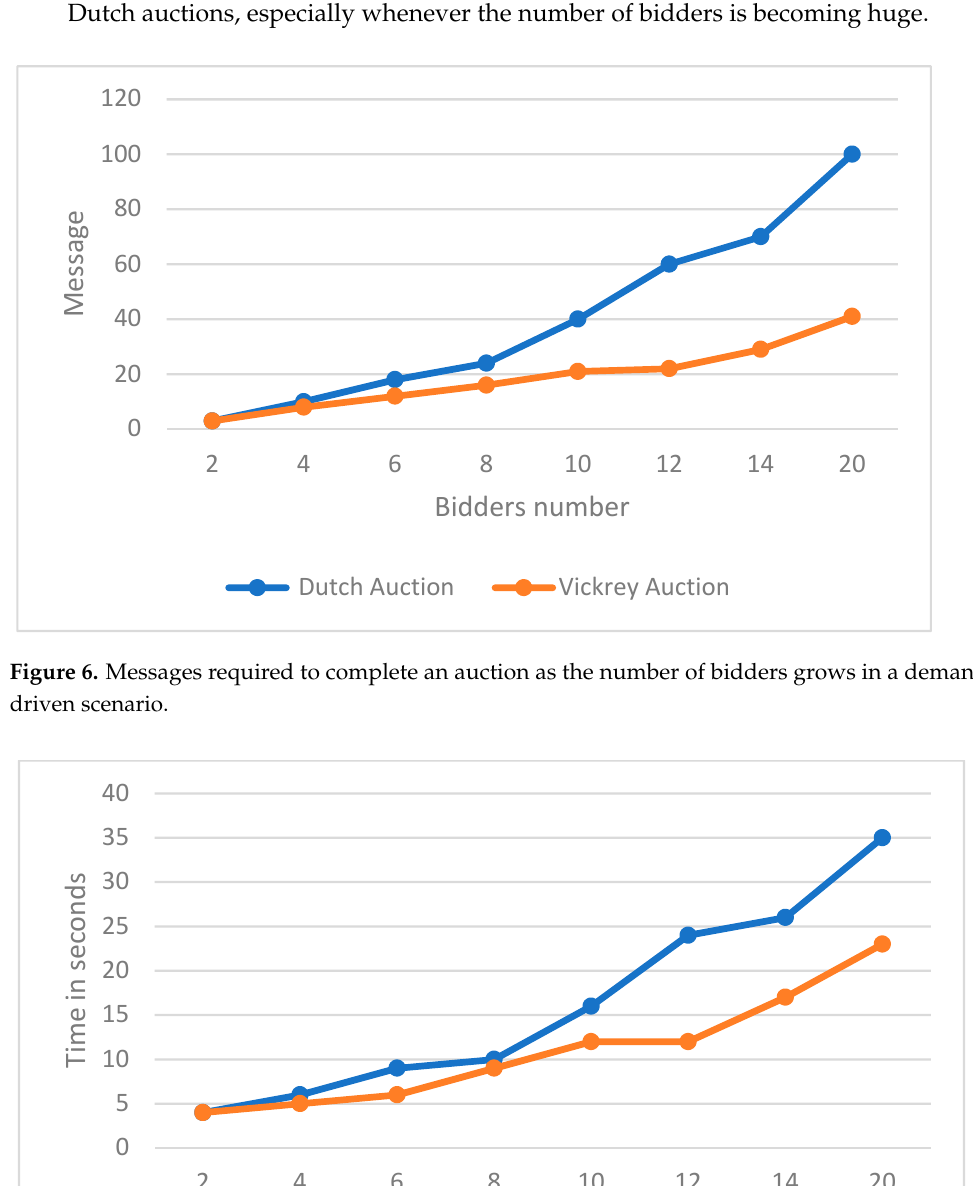
Figure 8. Messages required to complete an auction as the number of bidders grows in a supply- driven scenario.